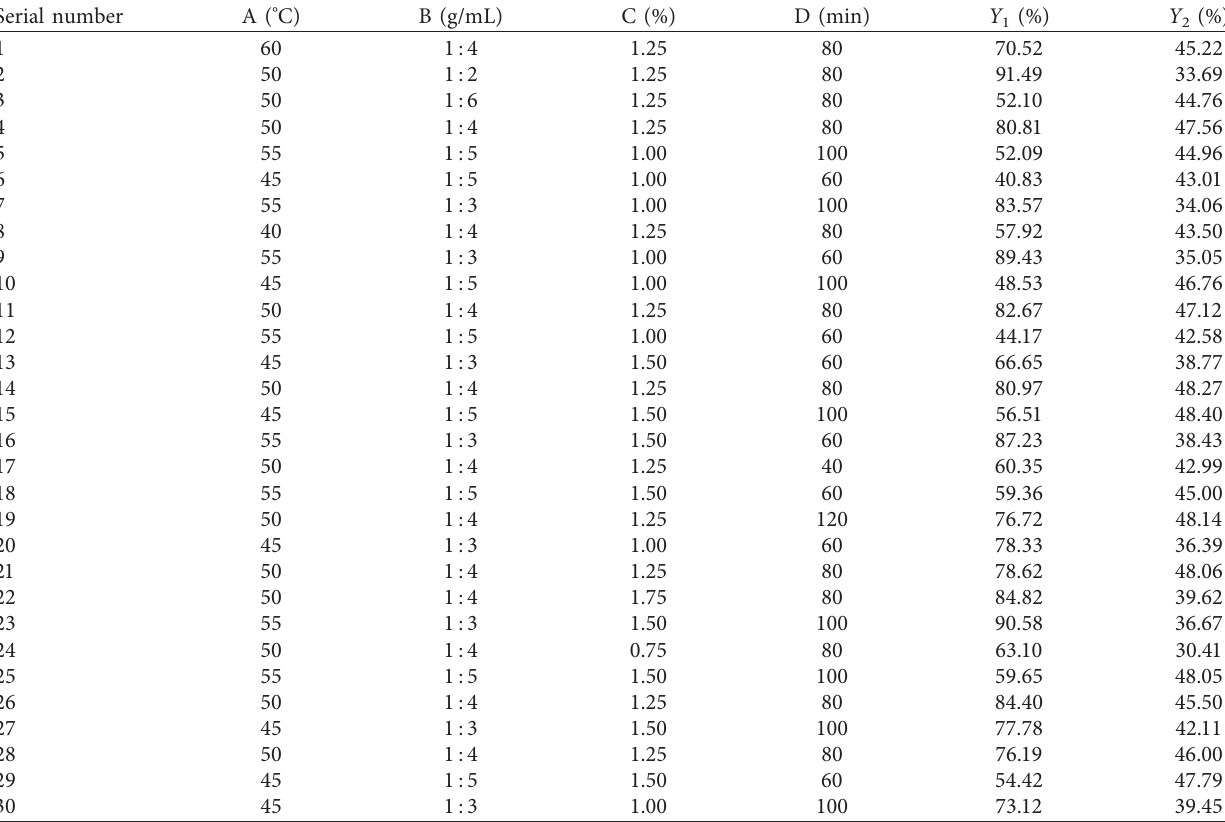
Table 3: Program and experimental results of response surface